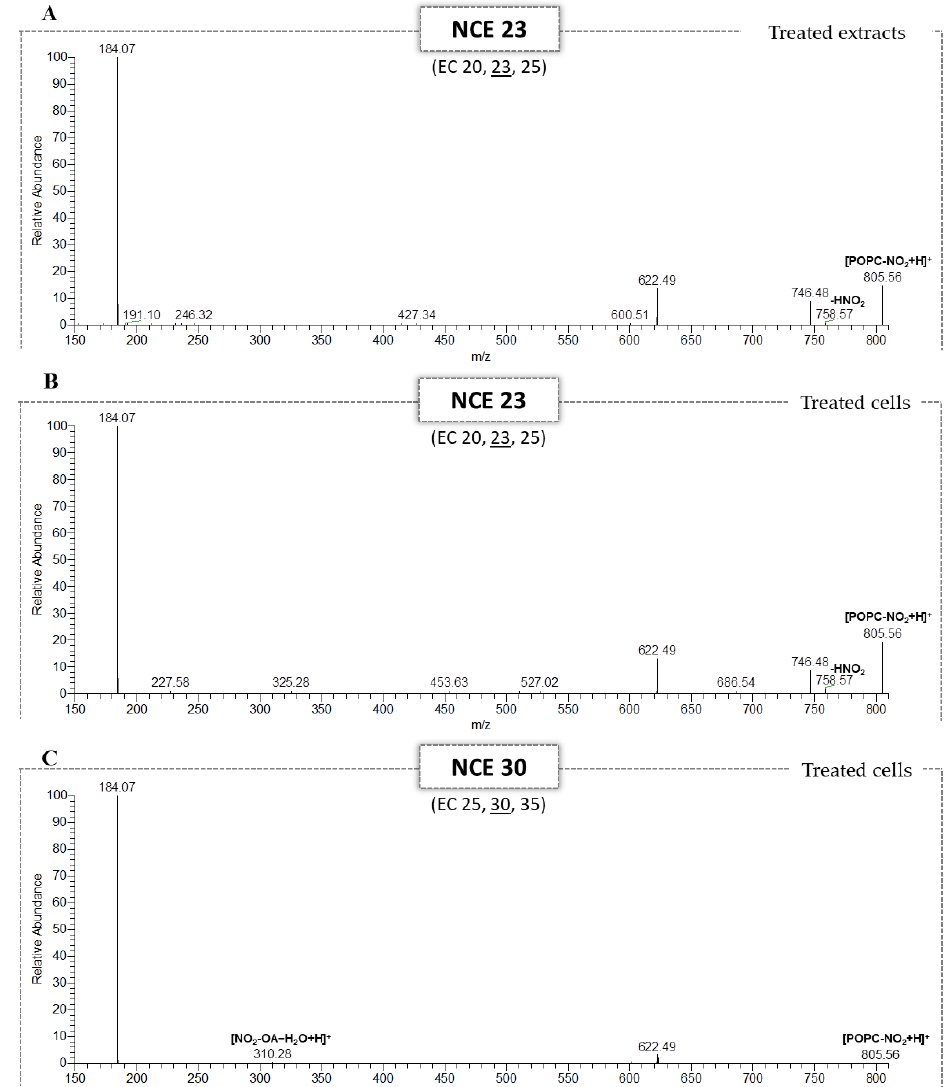
Figure 5. HILIC-HCD-MS / MS spectrum of NO 2 -POPC at m / z 805.56 identified in the lipid extracts treated with 8 µ g of nitrated POPC, obtained with an NCE = 23 ( A ). HILIC-HCD-MS / MS spectra of NO 2 -POPC at m / z 805.56 of the cellular lipid extracts from the SW13 / cl.2 cells treated with nitrated POPC obtained with a stepped NCE range of 20, 23 and 25 (NCE 23) ( B ) and 25, 30 and 35 (NCE 30) ( C ).